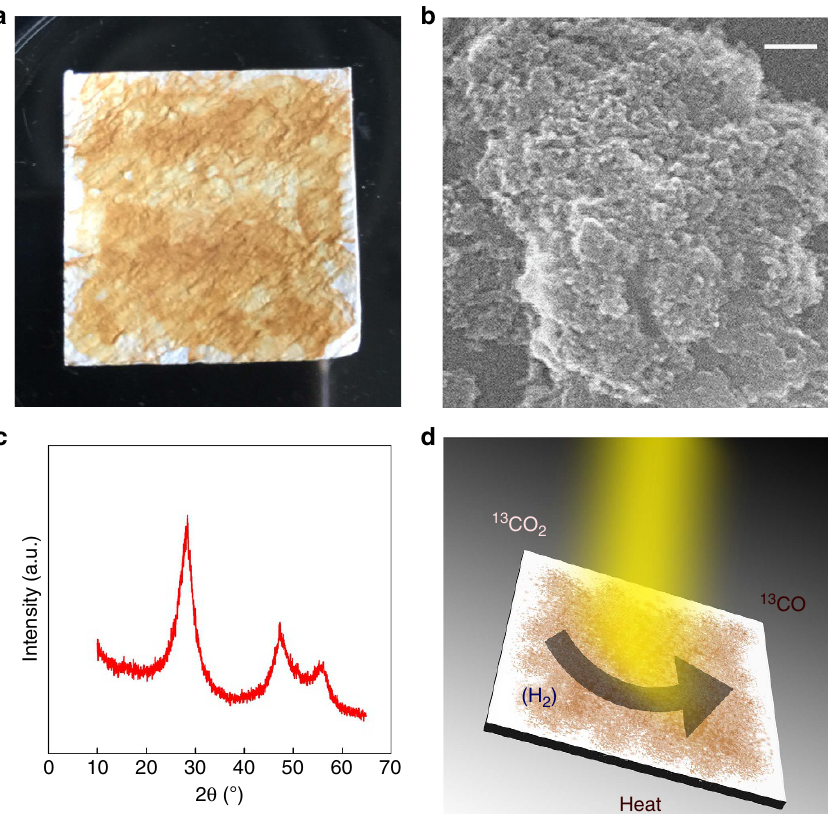
Figure 1 | Characterization of hydride-terminated ncSi. ( a ) As-synthesized powder comprised of ncSi:H deposited on a borosilicate glass fibre filter support. ( b ) SEM image of a film sample made of dried ncSi:H from a pentane dispersion. Scale bar, 100nm. ( c ) Powder X-ray diffraction pattern of ncSi:H, diffraction the main reflections peaks for nanocrystalline Si. ( d ) Schematic illustration of the reduction of CO 2 to CO by